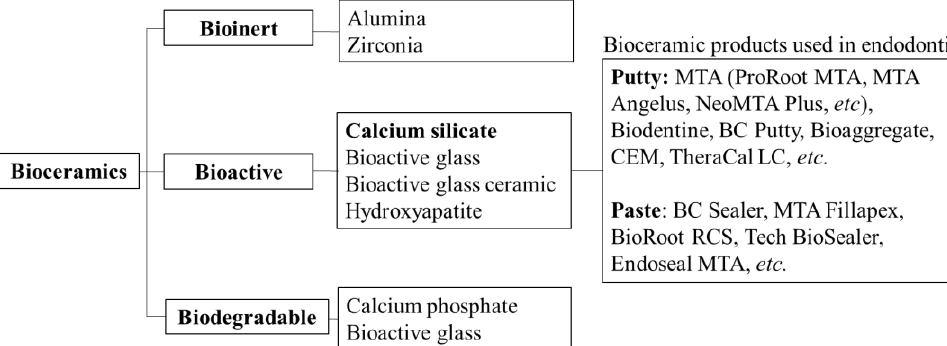
Figure 1. Classification of bioceramics.